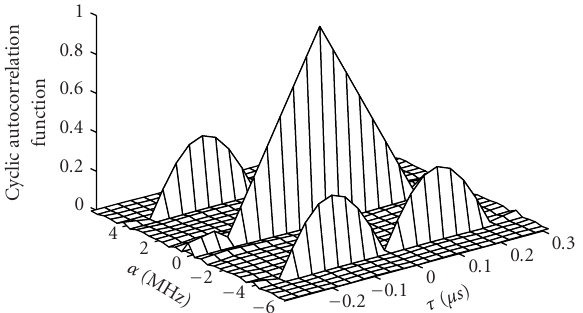
Figure 1: Magnitude of the BPSK cyclic autocorrelation function versus α and τ .